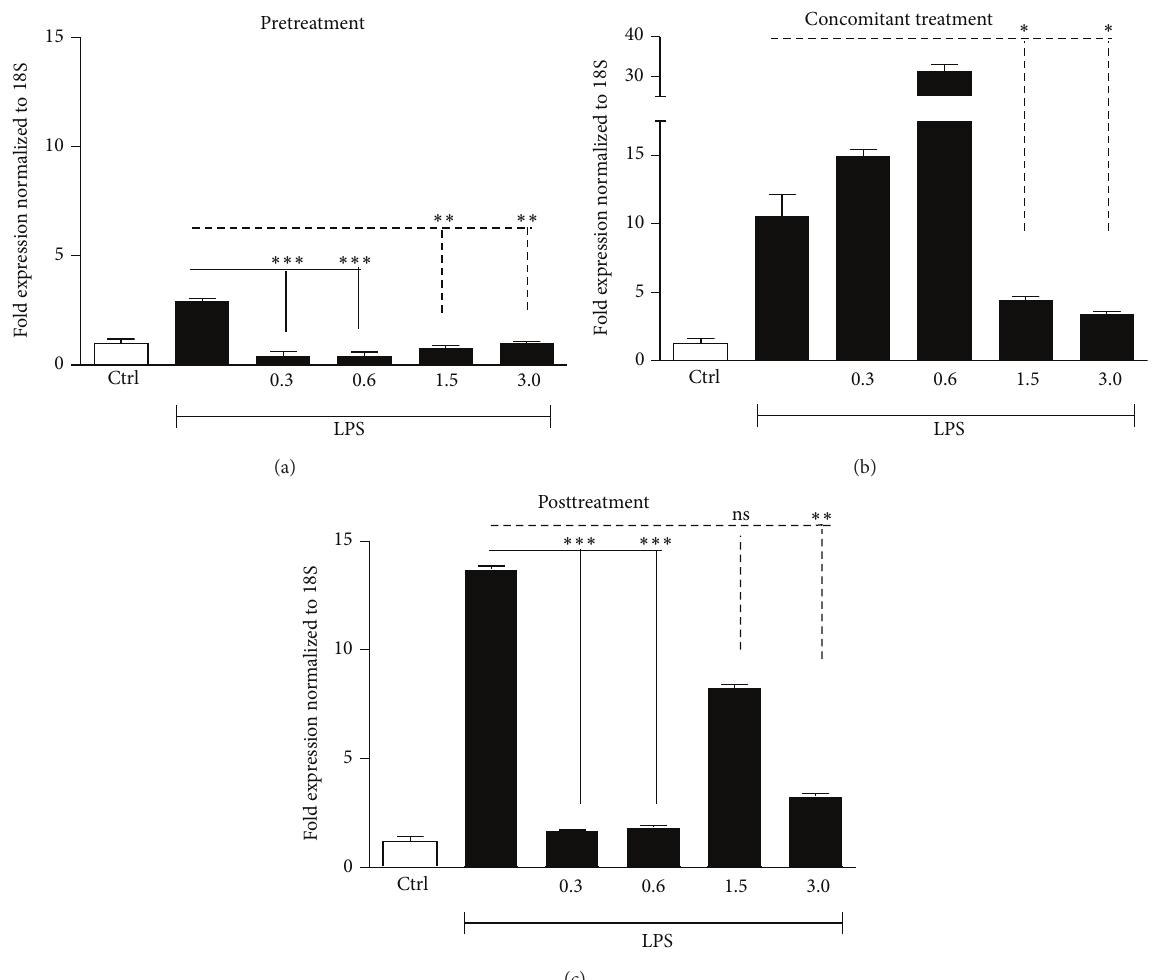
Figure4:TNF- 𝛼 geneexpression,analyzedthroughqRT-PCR,inHaCaTcellsstimulatedwithLPS(25 𝜇 g/mL)andincubatedinpretreatment, concomitant, and posttreatment settings with low (0.3mg/ 𝜇 L; 0.6 mg/ 𝜇 L) and high (1.5mg/ 𝜇 L; 3 mg/ 𝜇 L) doxycycline doses. TNF- 𝛼 gene expression in (a) cells stimulated with LPS for 24 h and successively incubated with doxycycline for further 24 h, mRNA extraction performed at 48h; (b) cells incubated with doxycycline immediately after LPS, mRNA extraction performed at 24 h; (c) cells pretreated with doxycycline for 24 h and successively stimulated with LPS, mRNA extraction at 48 h ( ∗ 𝑃 < 0.05 , ∗∗ 𝑃 < 0.01 , and ∗∗∗ 𝑃 < 0.001 ; ns: not statistically